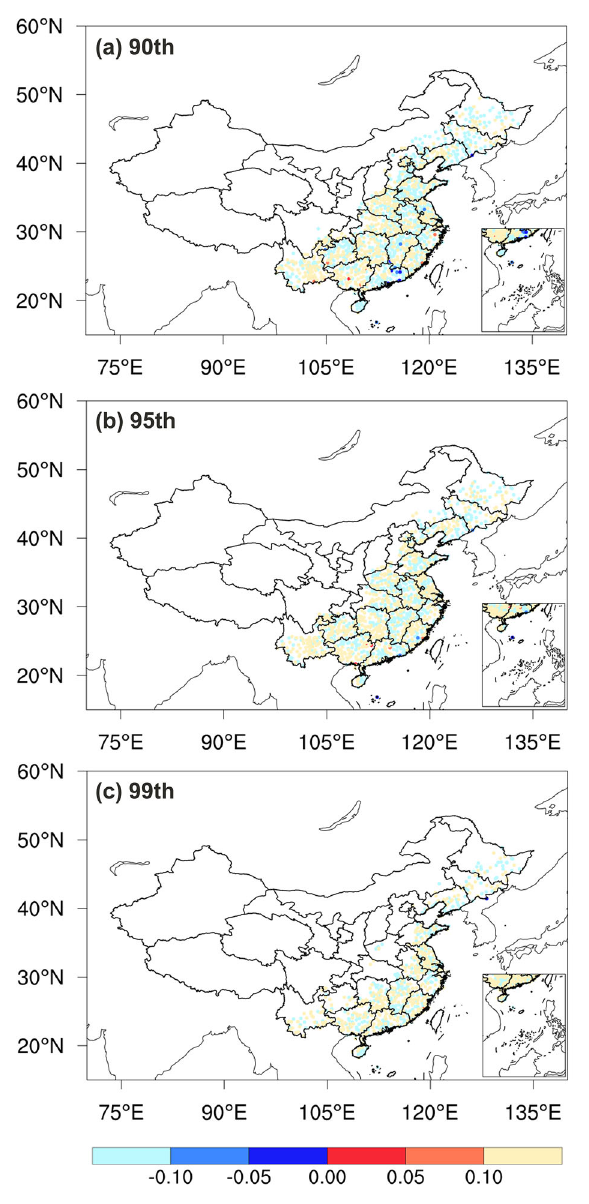
Fig. 6 Spatial distributions of trends in tropical cyclone (TC)- induced extreme precipitation obtained by peak-over-threshold (POT) sampling with 90th ( a ), 95th ( b ), and 99th ( c ) percentiles in the mainland of China. The trends were detected by the Poisson regression method and the values in each panel indicate the corresponding significance p values. The red (blue) p values indicate positive (negative) trends in TC-induced POT extreme